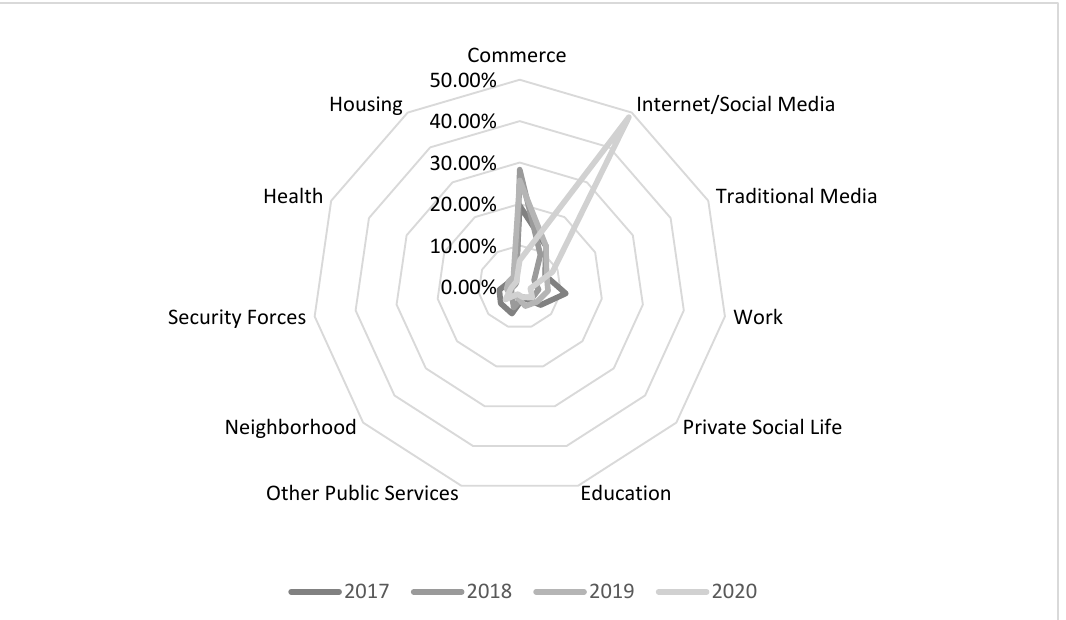
Figure 3. Reported discriminatory practices presented to CICDR by services ( n )—2017 to 2020. Source: Data retrieved from CICDR (2017, 2018, 2019, 2020).